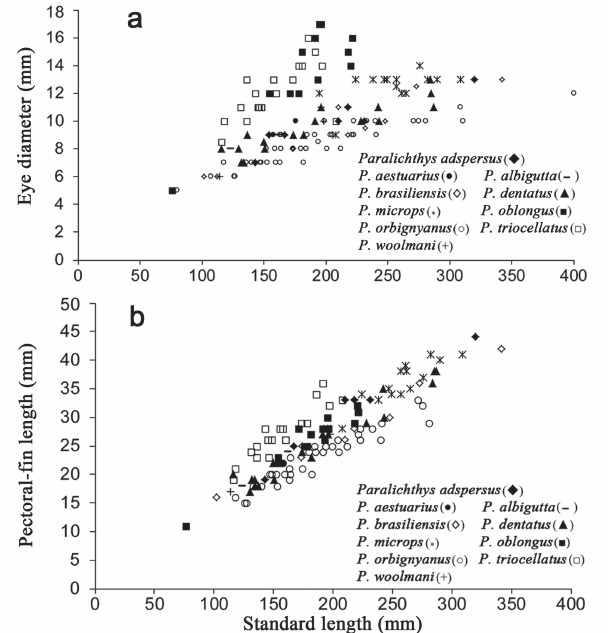
Fig. 7. Relationships of eye diameter to standard length ( a); and pectoral-fin length to standard length ( b ); in